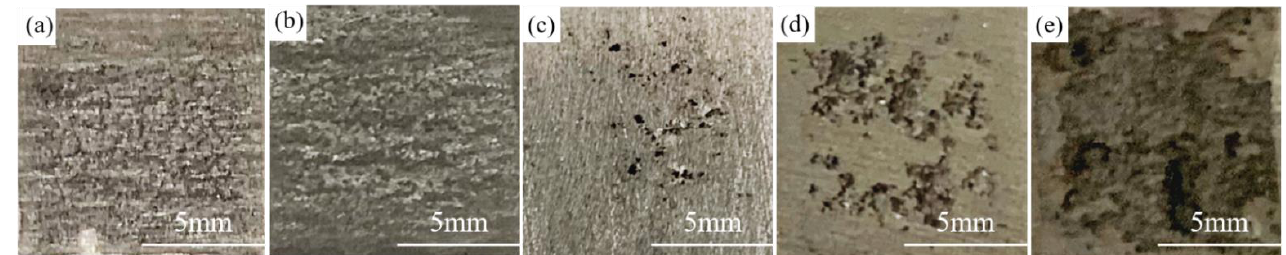
Figure 3. Optical images of Al anode being discharged at 10 mA cm −2 for 2 h in 2 M NaCl electrolyte ( a ) without and with different contents of GaCl 3 additive: ( b ) 0.05 M, ( c ) 0.1 M, ( d ) 0.15 M, ( e ) 0.2 M. According to the standard electrode potential φ θ (Ga 3+ /Ga) of −0.549 V, and φ θ (Al 3+ /Al) of −1.662 V [38], φ θ (Al 3+ /Al) < φ θ (Ga 3+ /Ga), and then, the following reaction occurs when